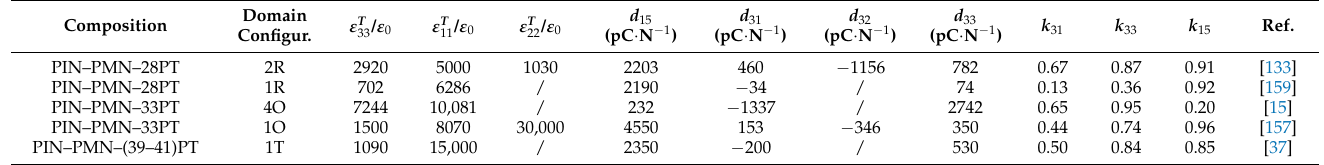
Table 5. Anisotropic properties of the second generation relaxor-PT ferroelectric